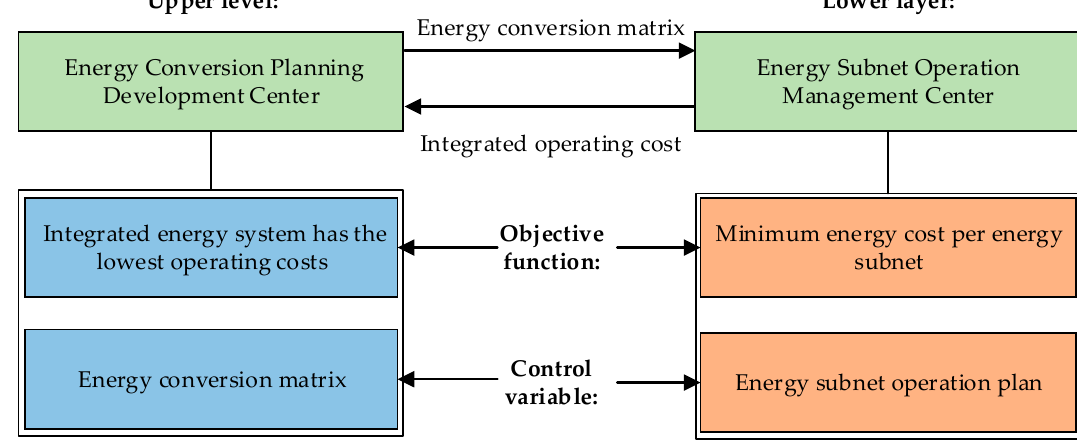
Figure 2. The information flow relation diagram of the bilevel programming model for an IES.